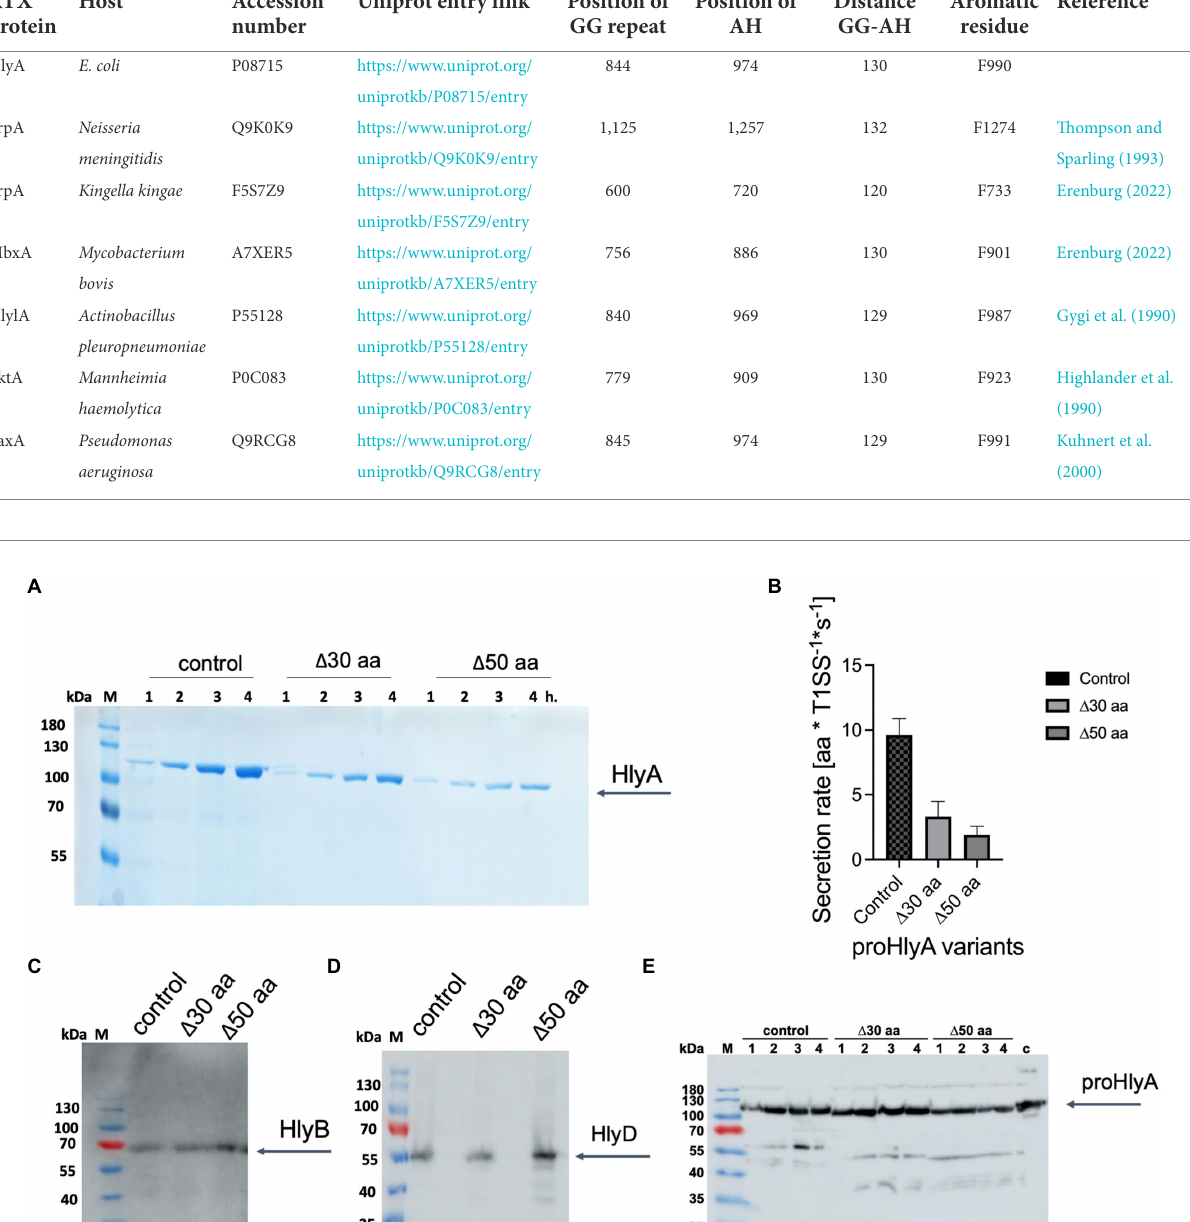
TABLE 4 A list of heterologous proteins that can be secreted by the HlyA T1SS.